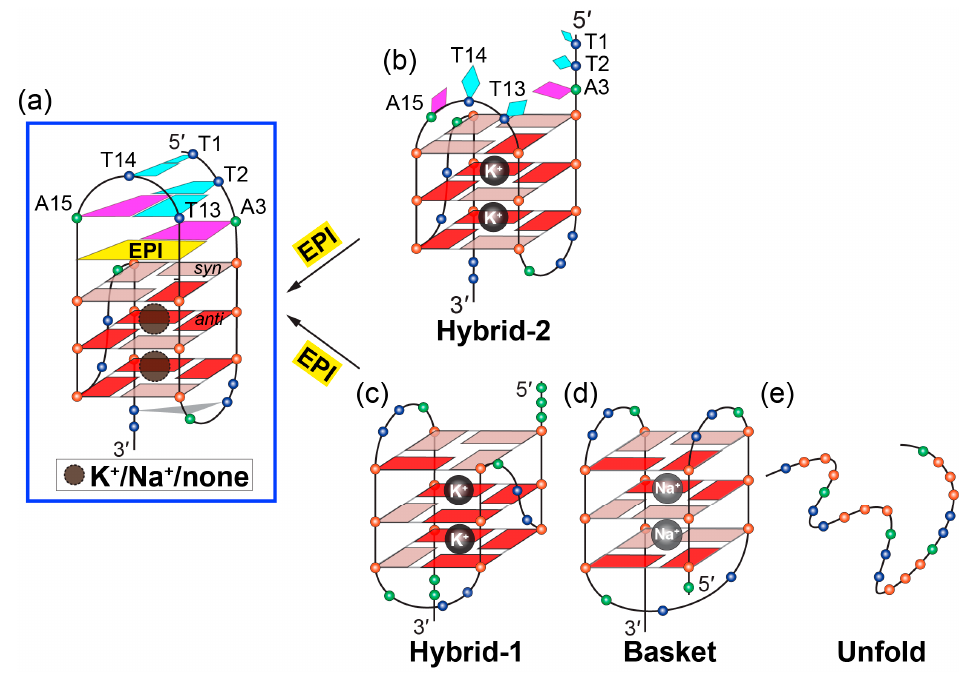
Figure 5. Conversion of human telomeric G-quadruplex structures to the hybrid-2 form induced by EPI. (a – b) EPI binding induces extensive rearrangement of previously disordered 5 ′ -flanking and lateral loop segments ( b ) to form a well-defined four-layer binding pocket ( a ) specific to hybrid-2 telomeric G-quadruplex. (c – e) Other human telomeric G-quadruplex forms, including hybrid-1 ( c ) and basket ( d ), or the free telomeric sequence in the absence of salt ( e ) can be converted to the hybrid-2 form as the addition of EPI molecules. The specific recognition of human hybrid-2 telomeric G-quadruplex by EPI (PDB ID: 6CCW).